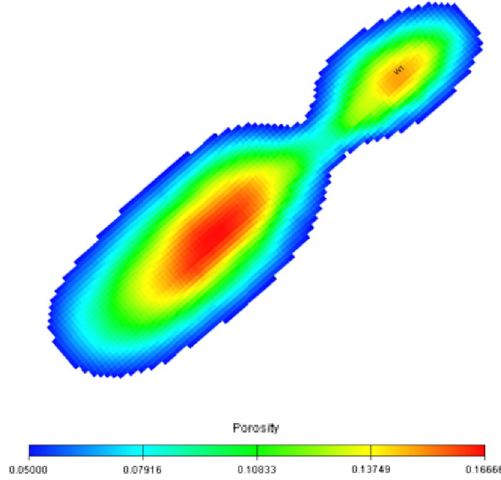
Fig. 4 Establishment of conceptual model for sidetracking